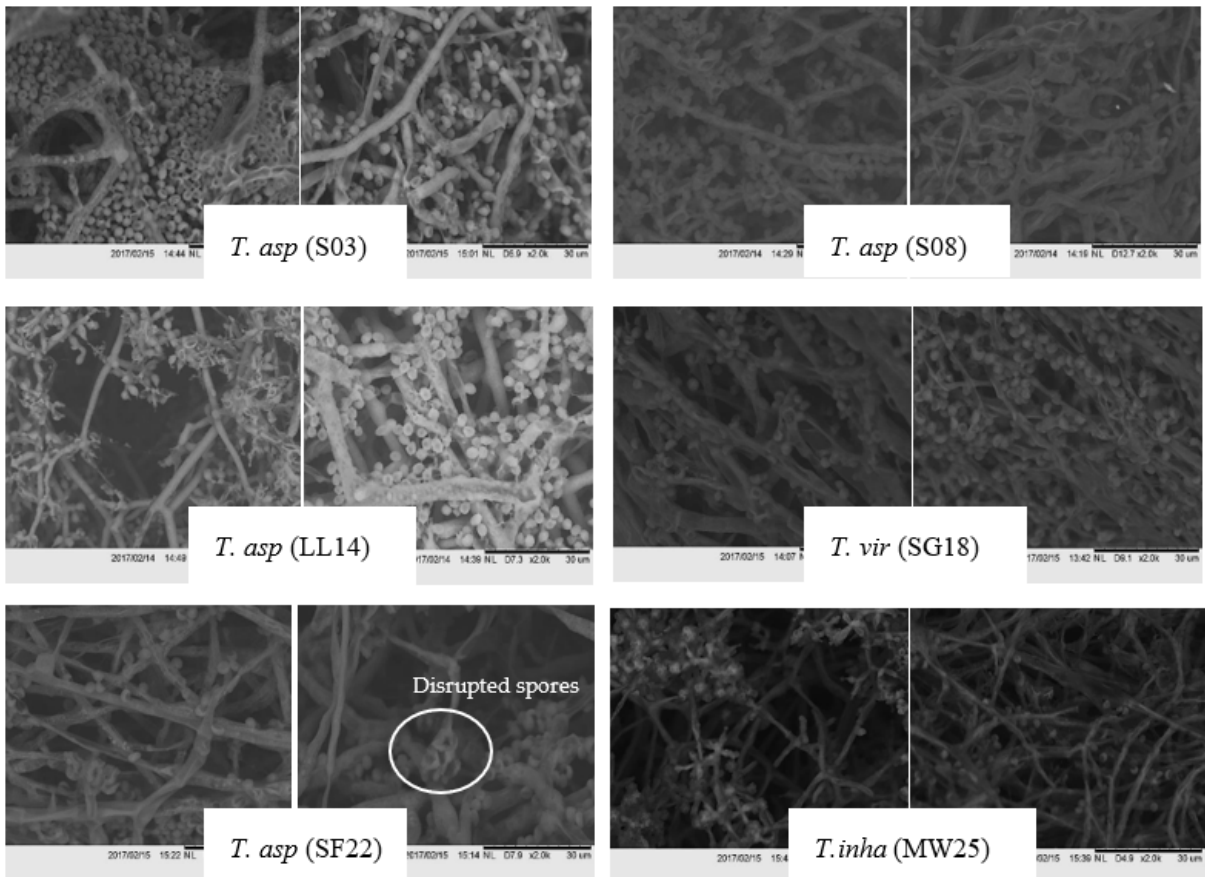
Figure 5. Scanning electron micrograph under a high magnification of 10,000 × of the six Trichoderma strains before (left) and after (right) exposure to 50-ppm nickel. The isolate and substrate codes were as follows: T. asperellum —soil (T. asp S03/S08), T. asperellum —leaf litter (T. asp LL14), T. asperellum —sea foam (T. asp SF22), T. virens —seagrass (T. vir SG18), and T. inhamatum —marine water (T. inha MW25).